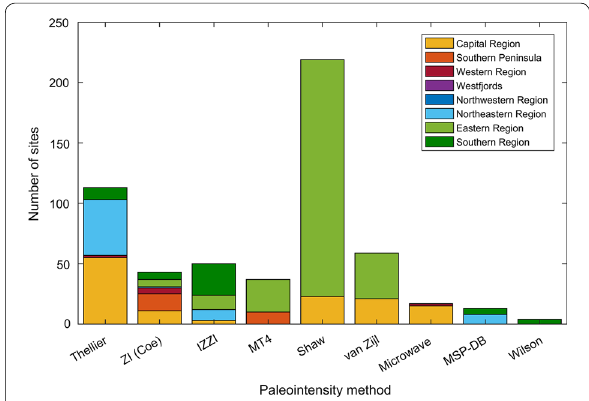
Fig. 13 Histogram of sites by palaeointensity method. Distribution of ICEPMAG sites by palaeointensity method, coloured by geographic region (legend